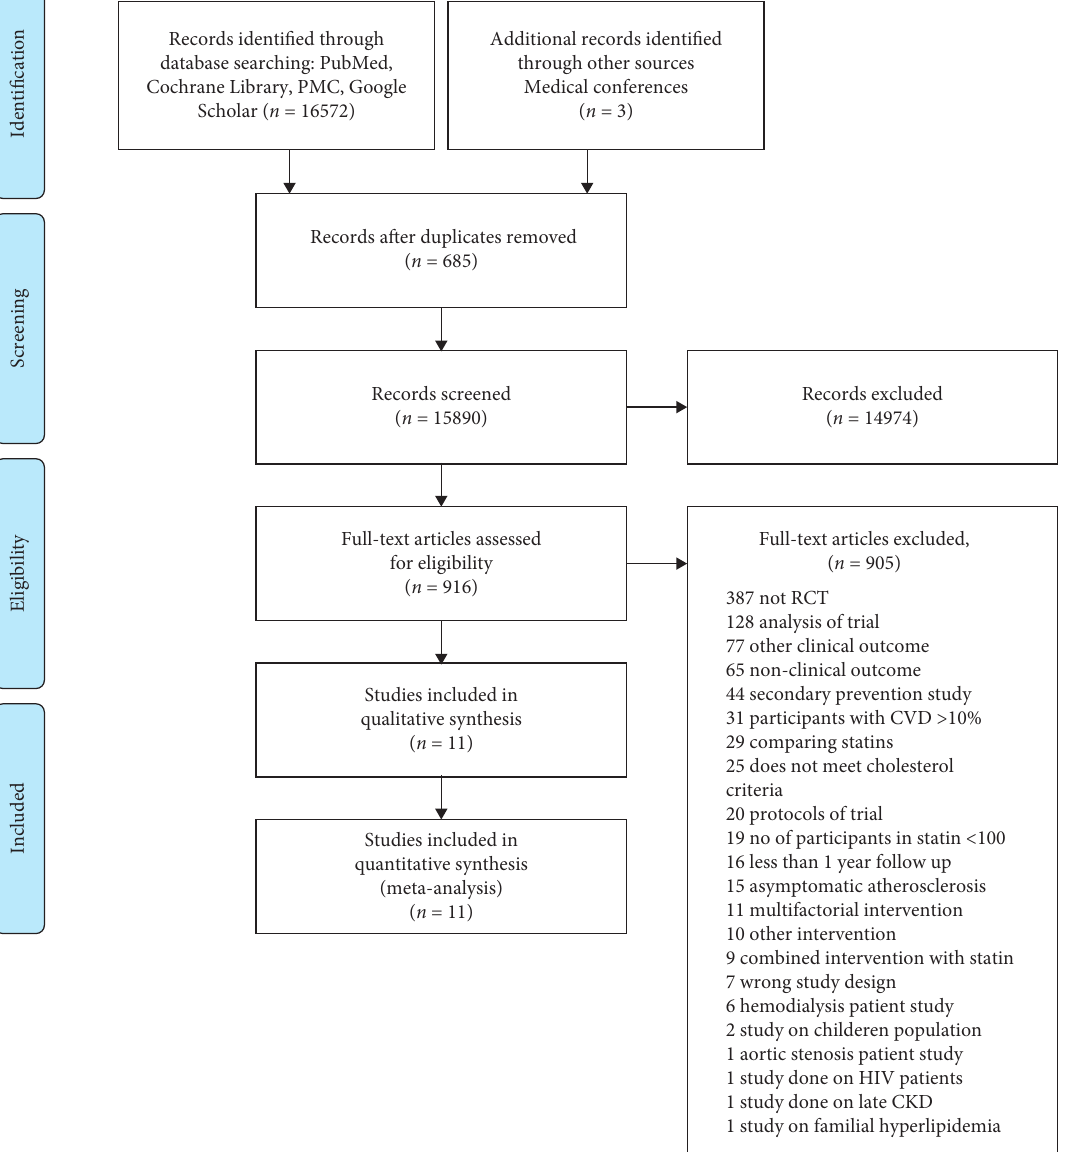
Figure 1: PRISMA flow diagram of the study search process. RCT, randomized controlled trial; CVD, cardiovascular disease; HIV, human immunodeficiency virus; CKD, chronic kidney